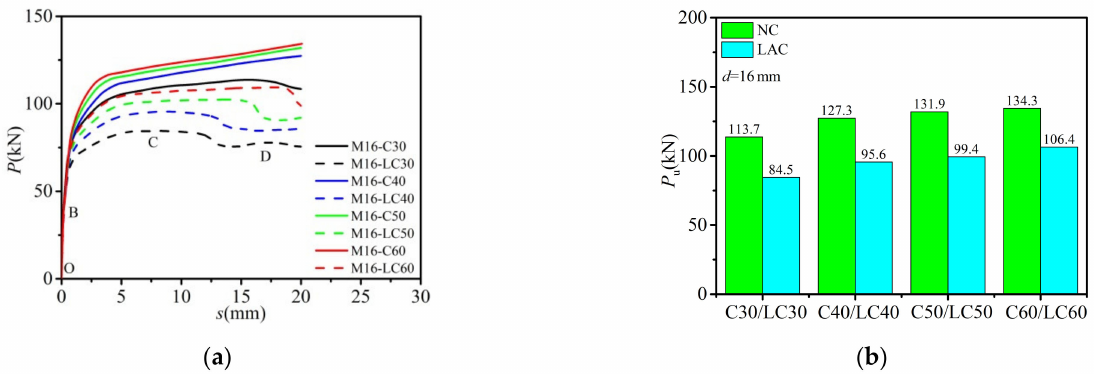
Figure 12. Comparison of shear behavior between the bolted connector embedded in LAC and NC: ( a ) force-slip relationship; ( b ) shear